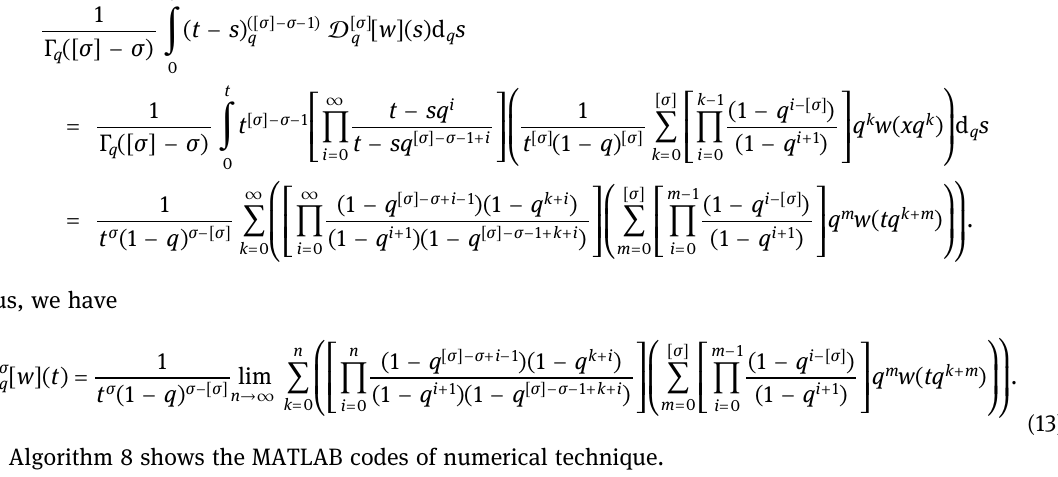
Algorithm 8. MATLAB lines for calculation